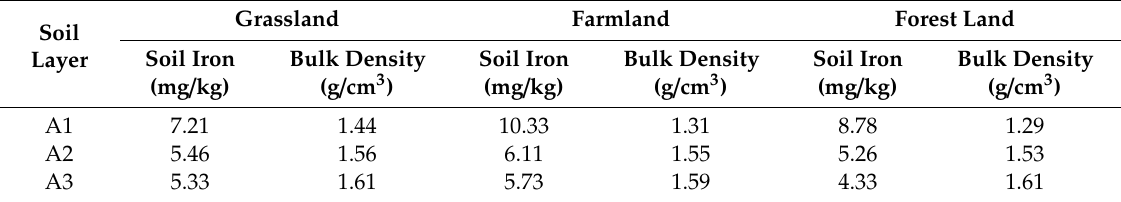
Table 3. Average soil iron content and bulk density of soil under di ff erent land uses. Grassland Farmland Forest Land Soil Soil Iron Soil Iron Layer